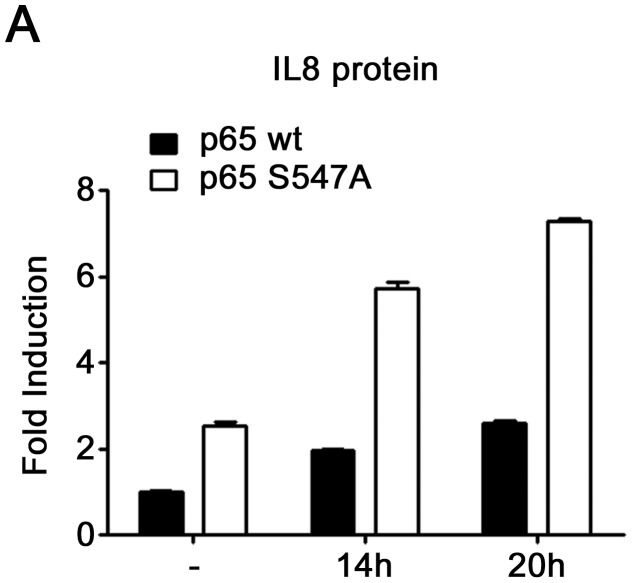
Higher IL8 protein level in cells expressing S547A mutated p65.ELISA analysis of IL8 protein level after the indicated times of etoposide treatment in HEK-293 cells expressing either p65wt or p65S547A.